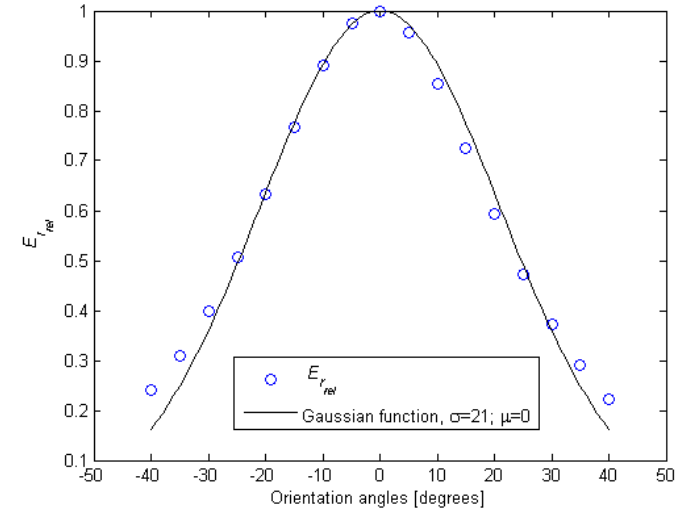
Figure 3. Measured behavior of E is used to fit this